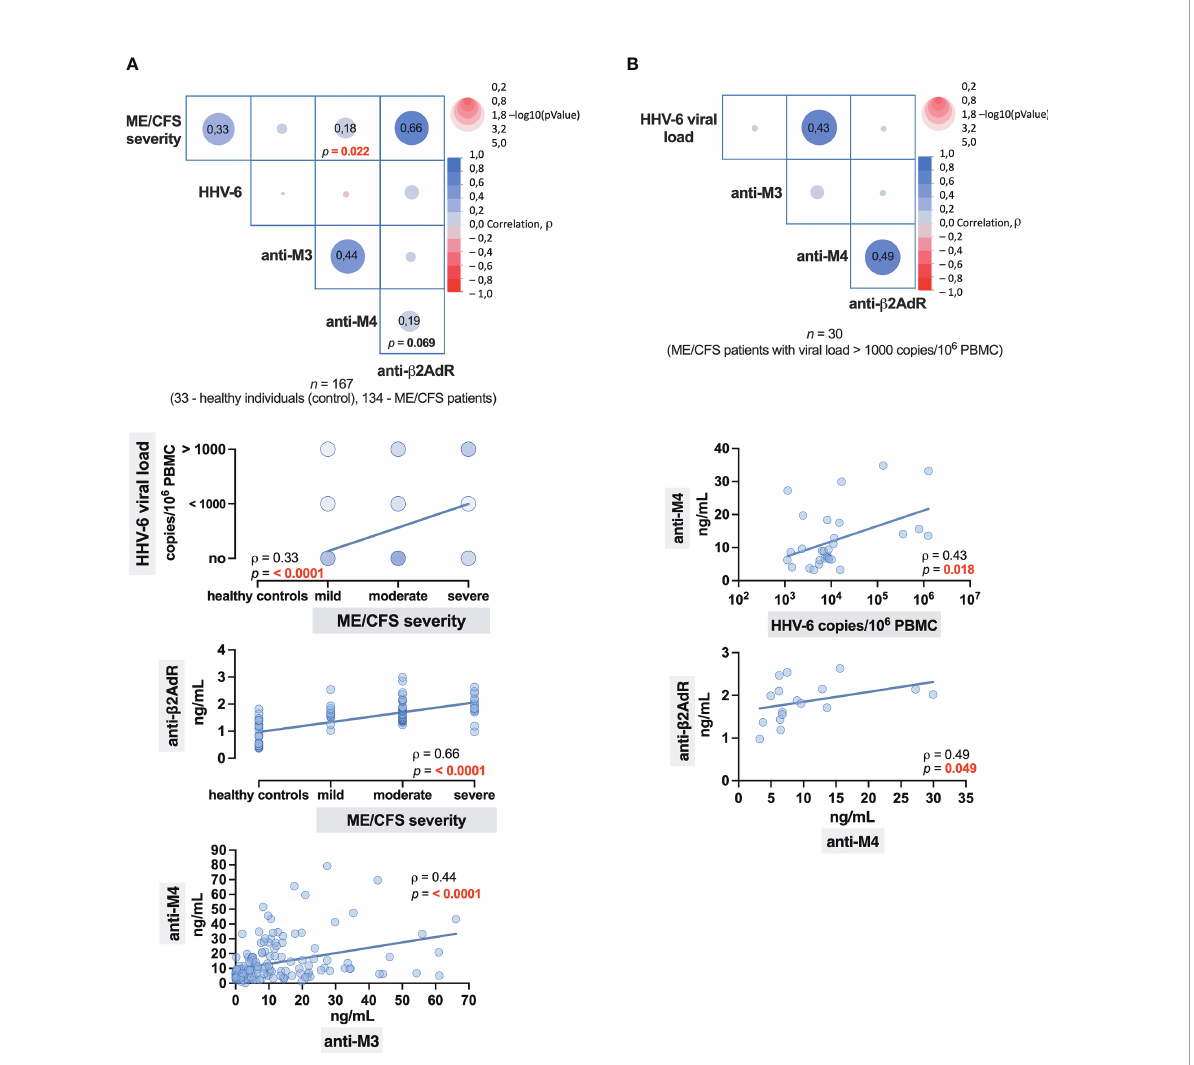
FIGURE 5 Correlation matrices with correlation graphs representing the strength of the association: (A) Between the ME/CFS severity and HHV-6 infection, and levels of antibodies to cholinergic M3 (anti-M3), M4 (anti-M4), and b 2 adrenergic (anti- b 2AdR) receptors. (B) Between the levels of HHV-6 viral load and anti-M3, anti-M4, and anti- b 2AdR. The numbers in cells (squares) show the value of the Spearman ’ s rank correlation coef fi cient rho ( r